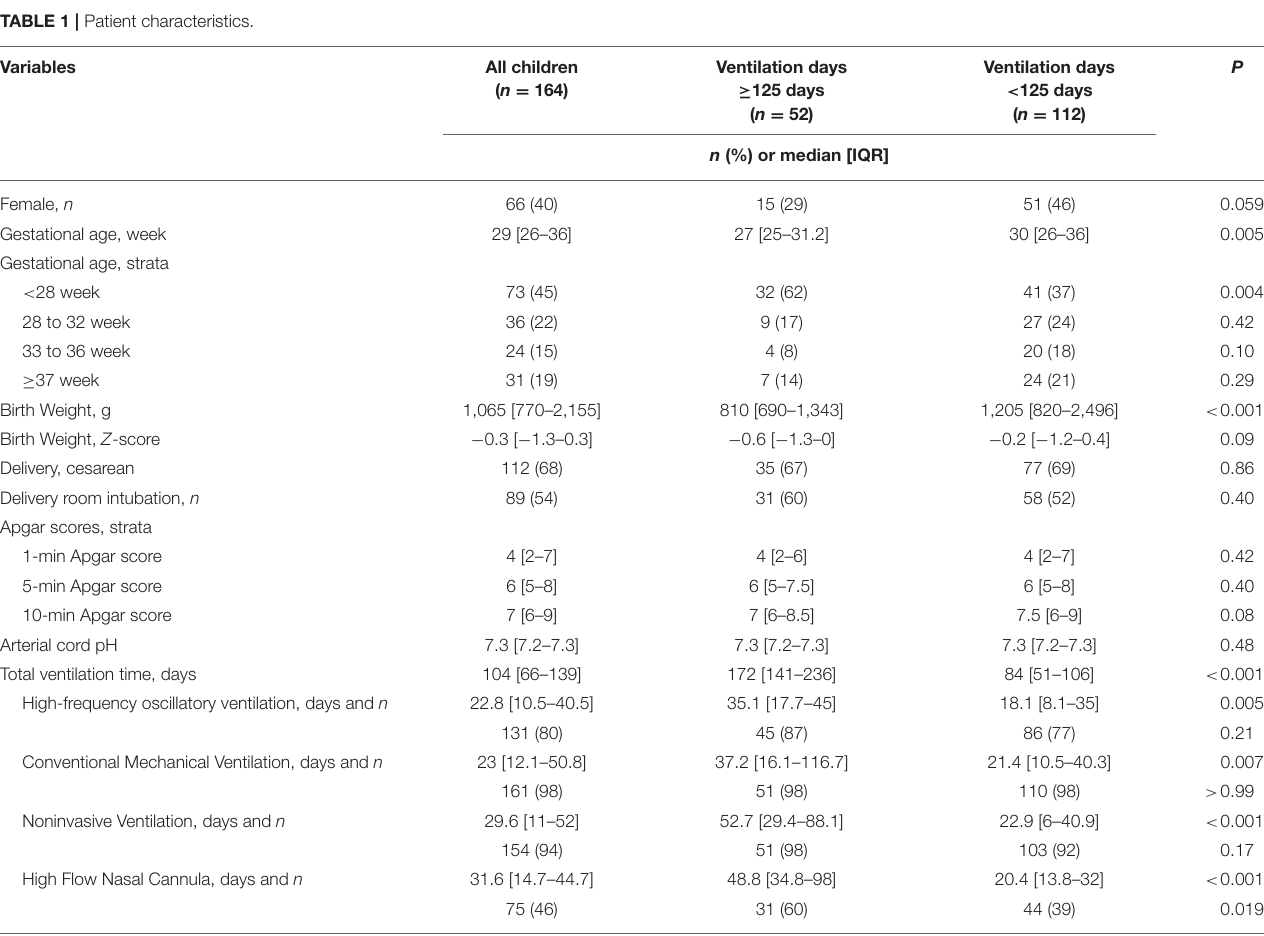
TABLE 1 | Patient